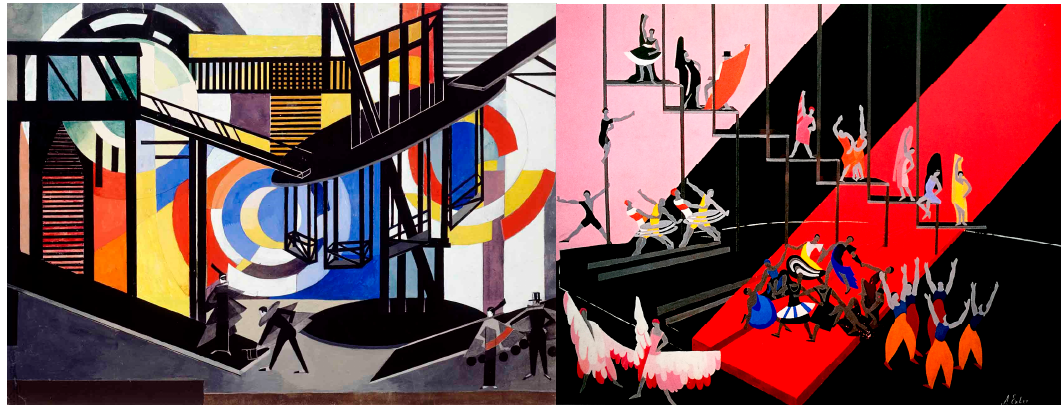
Figure 4. On the left , A. Exter, sketch for the scenography of The Phantom Lady by Calderón, 1924; on the right , A. Exter, Sketch of the scenography for a Journal ,